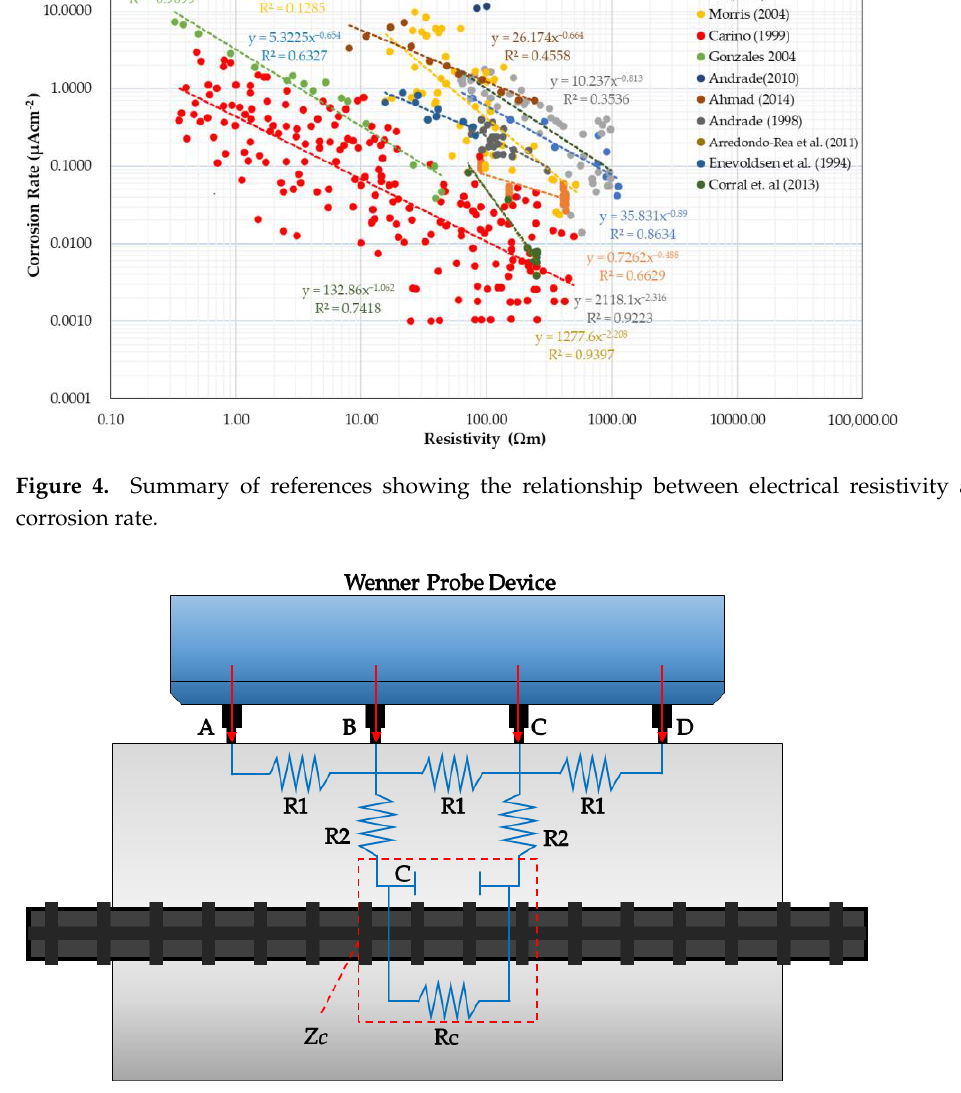
Figure 5. Equivalent electric circuit for electrical resistivity measurement using the four-point Wenner